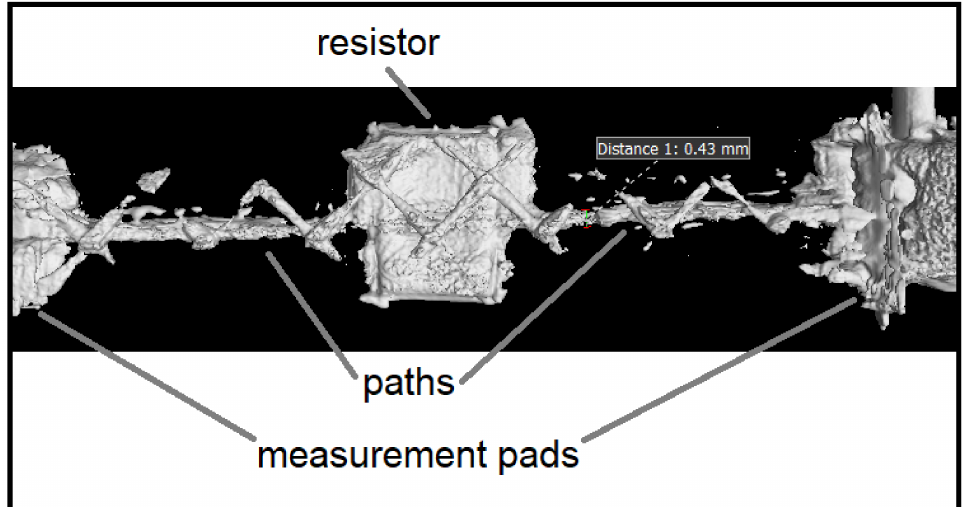
Figure 4. X-ray computed tomography model of sample after accelerated life testing. Initially, the printed trace had about 0.5 mm. The visible X marks are CT artifacts representing the polymer substrate.